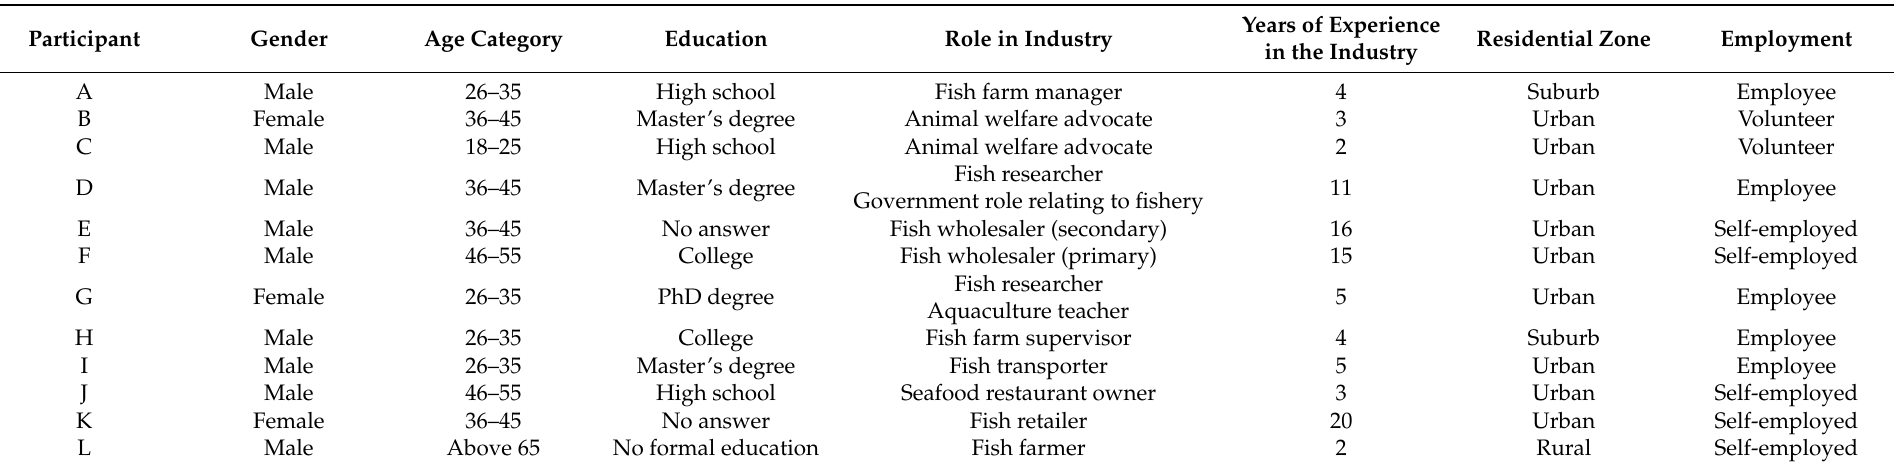
Table 1. Demographic data of 12 participants (A–L) in China, from a survey investigating the knowledge and attitude of stakeholders in Chinese aquaculture industries on live transport of farmed